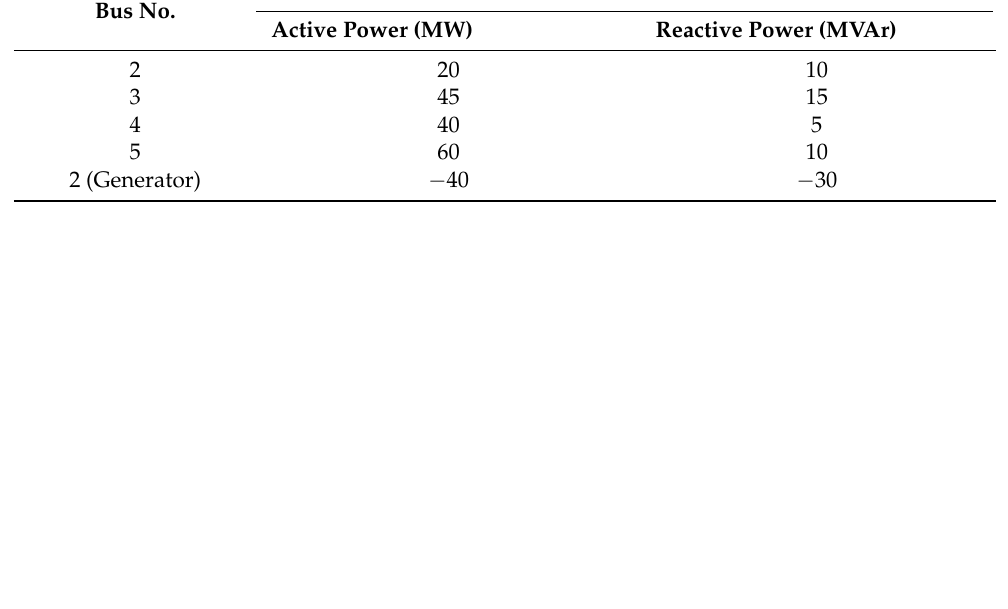
Table A1. Bus data of the IEEE 5-bus test distribution system. Bus